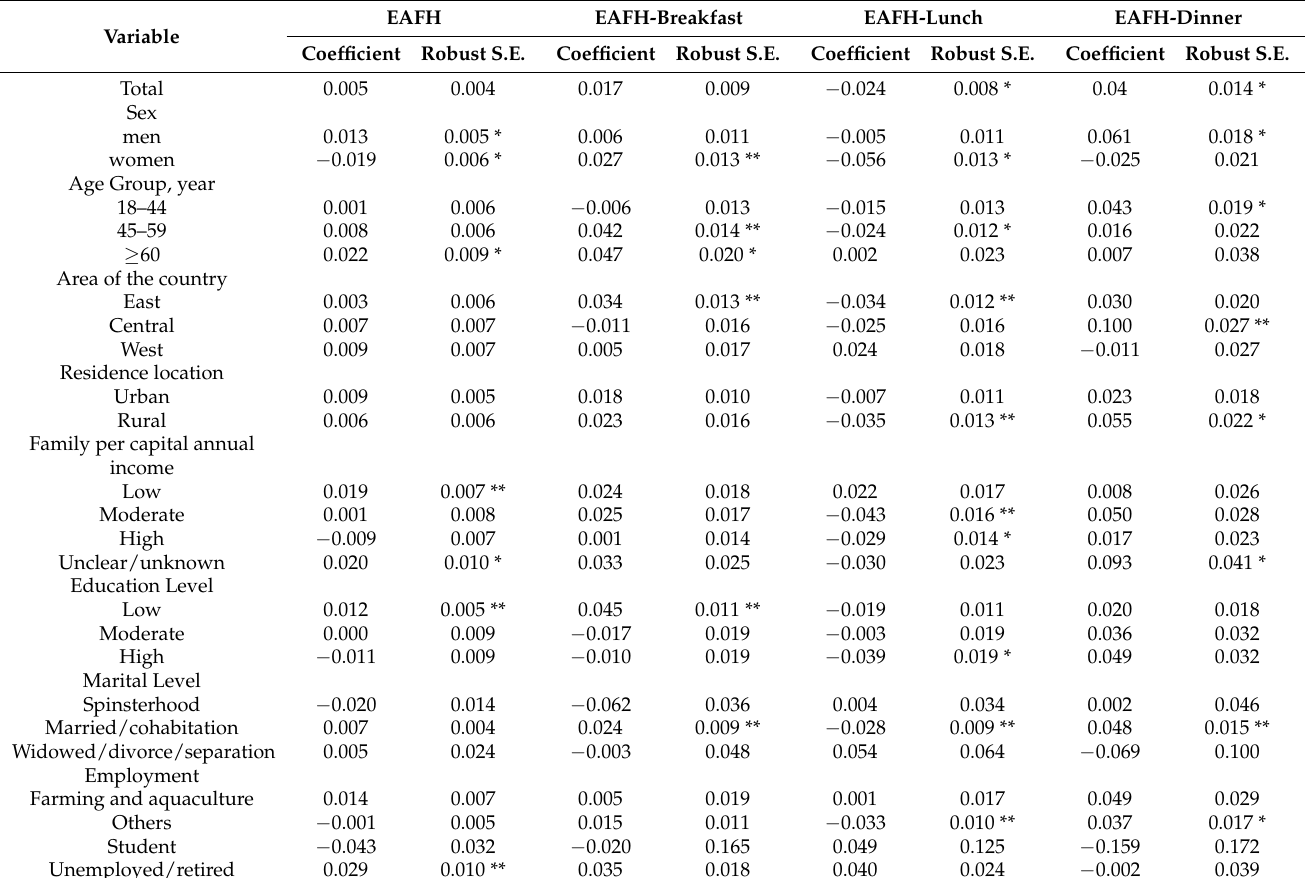
Table 2. Association between eating away from home (EAFH) and